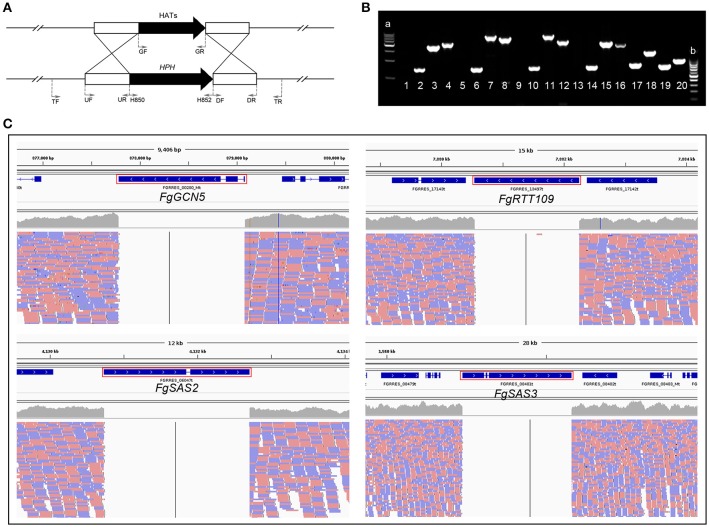
Deletion of four HATs from the genome of wild-type strain PH-1, respectively. (A) Schematic representation gene disruption strategy. HAT gene and the hygromycin resistance cassette (HPH) are denoted by black and arrows. The annealing sites of primers UF/UR, DF/DR, TF/TR, GF/GR, H850/H852 are indicated by small black arrows. (B) Electropherogram of PCR products. a: 500 bp DNA ladder maker; b: 100 bp DNA ladder maker; Lane 1, 5, 9, 13: PCR products amplified with primers GF/GR using ΔFgRTT109, ΔFgSAS2, ΔFgSAS3 and ΔFgGCN5 as a template, respectively; Lane 2, 6, 10, 14: PCR products amplified with primers H850/H852 using ΔFgRTT109, ΔFgSAS2, ΔFgSAS3, and ΔFgGCN5 as a template, respectively. Lane 3, 7, 11, 15: PCR products amplified with primers TF/H852 using ΔFgRTT109, ΔFgSAS2, ΔFgSAS3, and ΔFgGCN5 as a template, respectively. Lane 4, 8, 12, 16: PCR products amplified with primers H850/TR using ΔFgRTT109, ΔFgSAS2, ΔFgSAS3, and ΔFgGCN5 as a template, respectively. Lanes 17-20: PCR products amplified with primers GF/GR using FgRTT109c, FgSAS2c, FgSAS3c, and PH-1 as a template, respectively. (C) Genome re-sequencing of four mutants. The location of FgGCN5, FgRTT109, FgSAS2, FgSAS3, and on chromosomes was marked in red box.